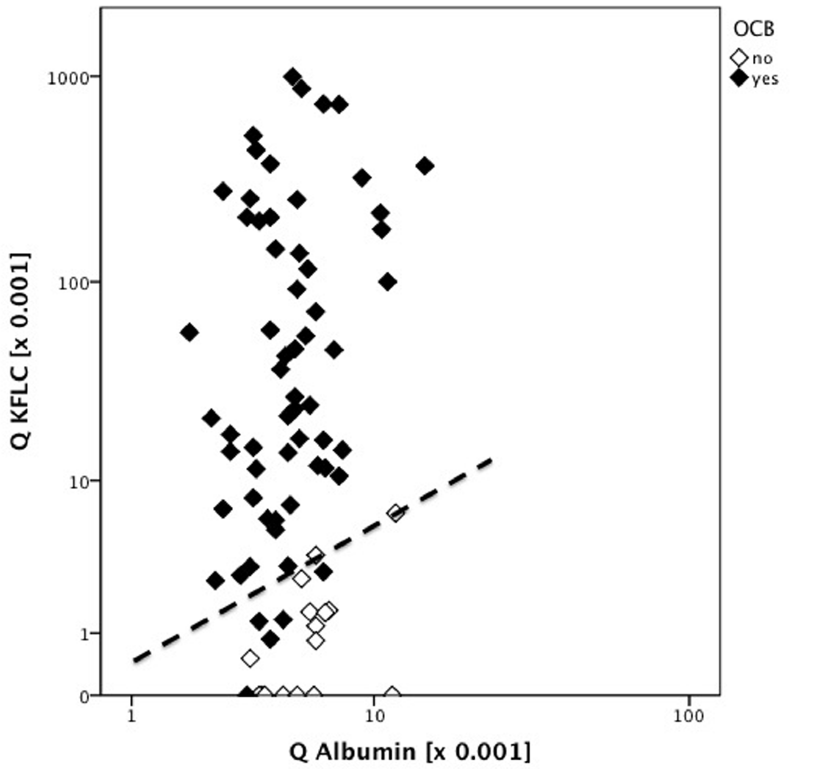
Figure 3. CSF-serum ratio of KFLC (Q KFLC) was elevated in patients with positive oligoclonal IgG (OCB). Q KFLC of 77 CIS patients are shown. Dashed line indicates the approximately upper reference value of Q KFLC, described in figure 2. Black rhomb indicate positive OCBs, white rhomb indicate negative OCBs.